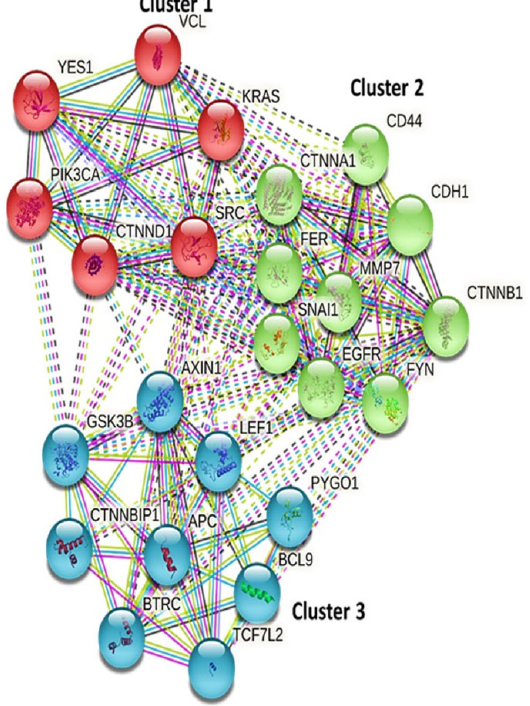
Figure 6. STRING database predicted protein ‐ protein interacting networks (PINs) among oncogenic markers of the KRAS/MMP7/CD44 gene signatures. Three clusters of interacting networks were constructed from the three genes. Furthermore, interactions among the correlated genes are displayed based on experimental data (pink), gene neighborhoods (green), gene fusion (red), gene co ‐ occurrences (blue), and gene co ‐ expressions (black). Associations were detected of KRAS with CTNNB1, KRAS with CD44, CDH1 with CD44, MMP7 with CD44, MMP7 with KRAS, and CTNNB1 with MMP7. Moreover, protein enrichment of p < 1.0 x 10 − 16 was obtained from the clustering analysis, with a coefficient of 0.772.